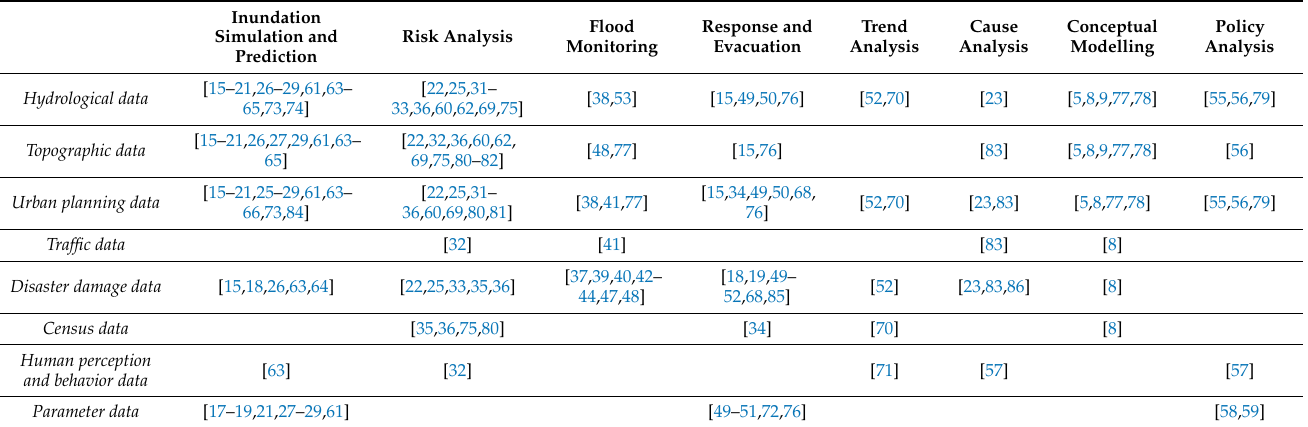
Table 1. Tasks, data, and their